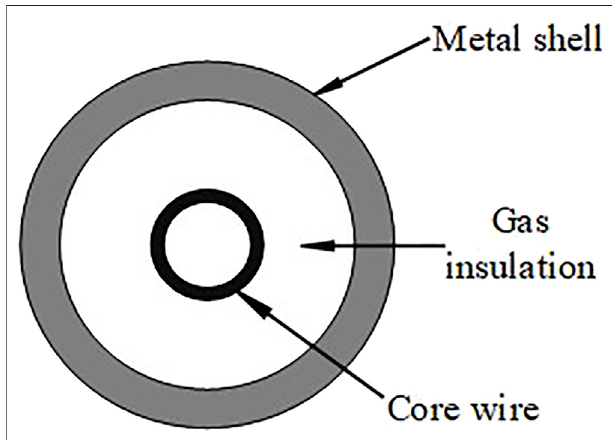
FIGURE 1 | Schematic diagram of GIL geometry.